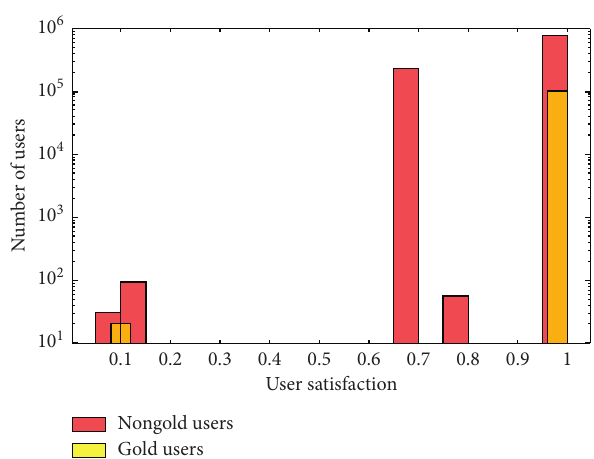
Figure 8: Simulated average customer satisfaction with 10% gold users.